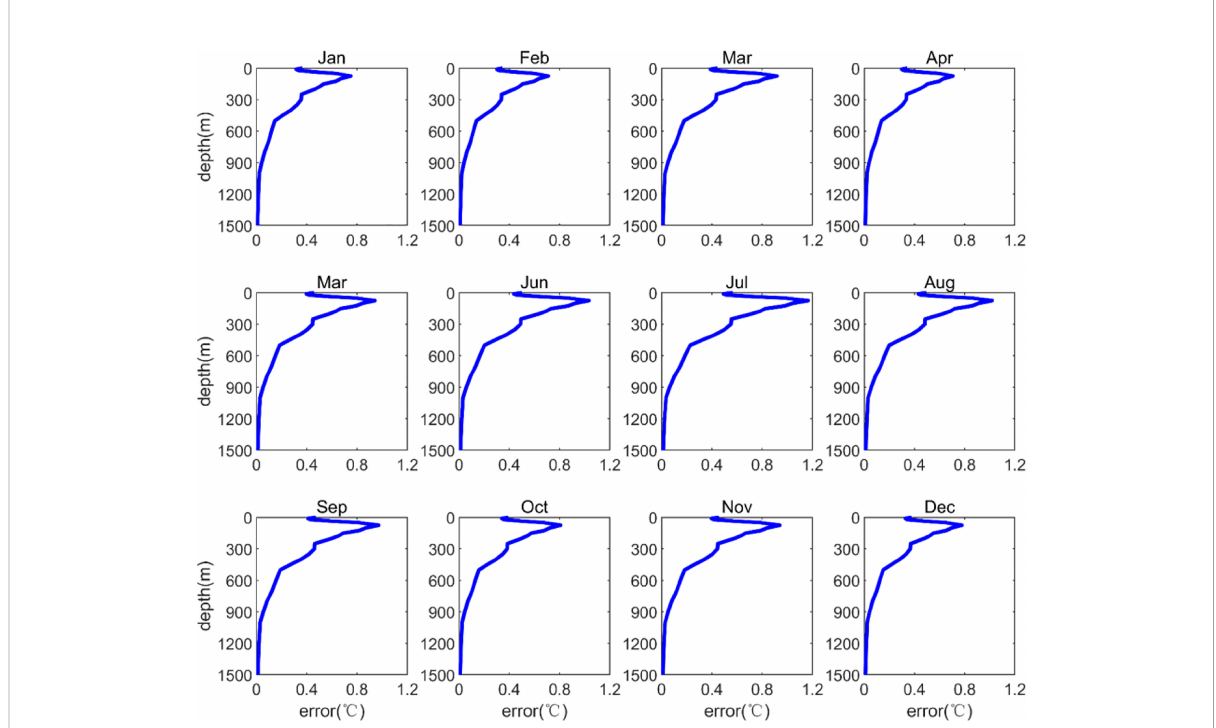
FIGURE 10 Vertical distribution of expanded temperature fi eld monthly errors in the northern South China Sea (cross-validation tests).